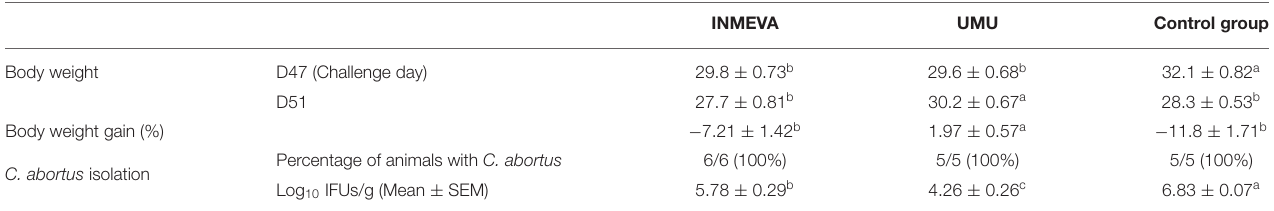
TABLE 2 | Presence of reproductive disorders caused by C. abortus , average number of pups per mice, the percentage of liver and uterus samples with presence of C. abortus and the average titration of C. abortus from liver and uterus samples (log IFU/g of tissue) of pregnant mice per group. INMEVA UMU Control Sentinel Reproductive disorders caused by C. abortus Number of pups per mice (Mean ±